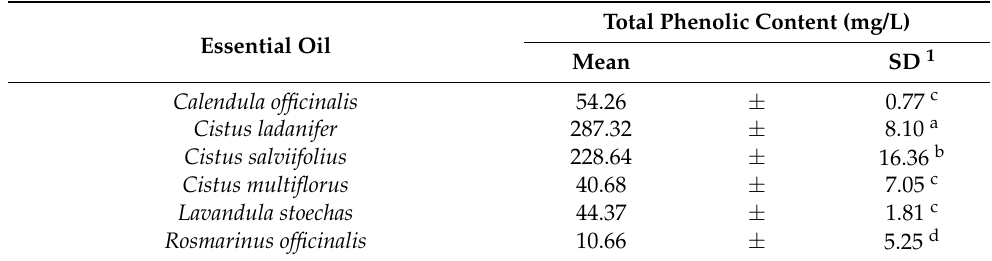
Table 1. Total phenolic compounds (mg/L) of essential oils obtained from aromatic